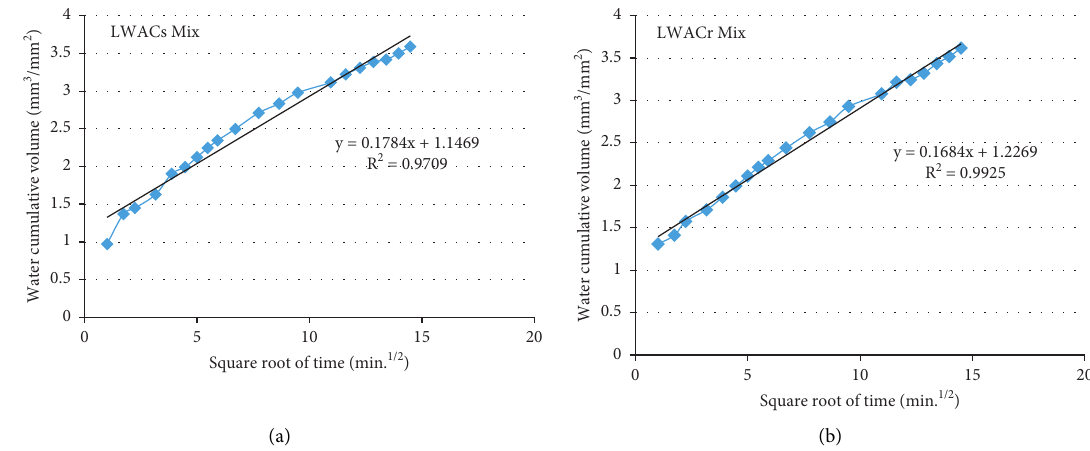
Figure 11: Sorptivity obtained from the i versus t 0.5 curve using a best fit linear regression (in mm/min 0.5 ) (a) LWACs mix and (b) LWACr